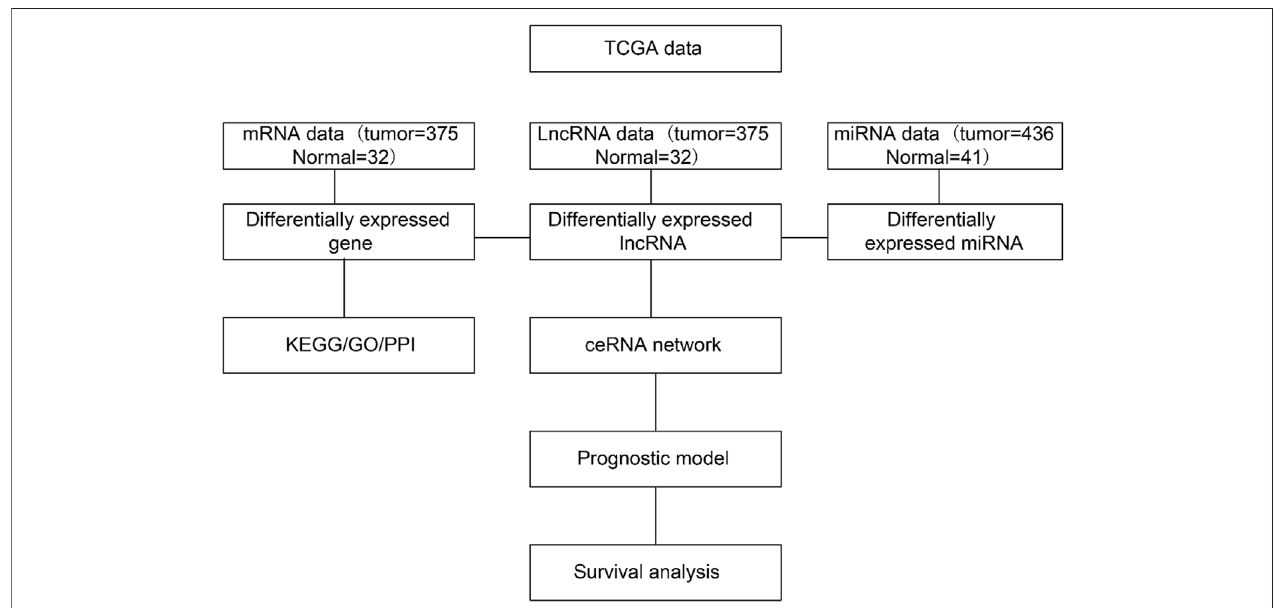
FIGURE 1 | Bioinformatics pipeline to construct the competitive endogenous RNA (ceRNA) network. DERNA, differentially expressed RNA; lncRNA, long noncoding RNA; miRNA, micro RNA; mRNA, messenger